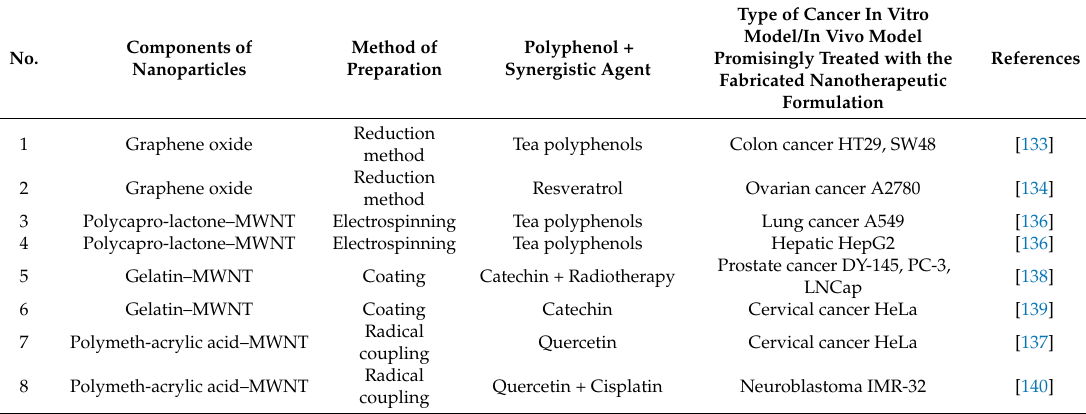
Table 6. Polyphenol-loaded carbon-based nanohybrids for the treatment of